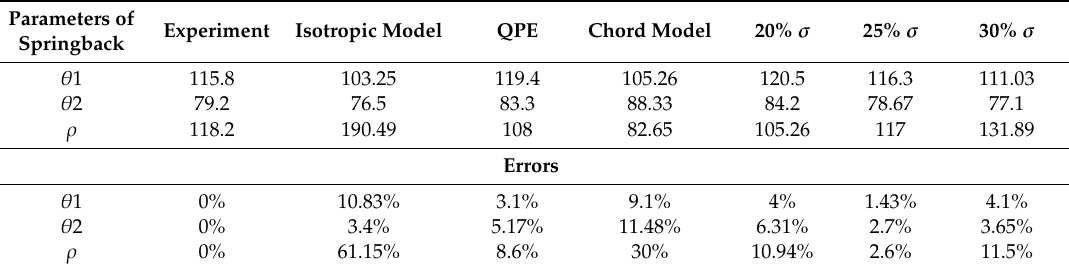
Table 2. Measurement of the parameters and errors of springback